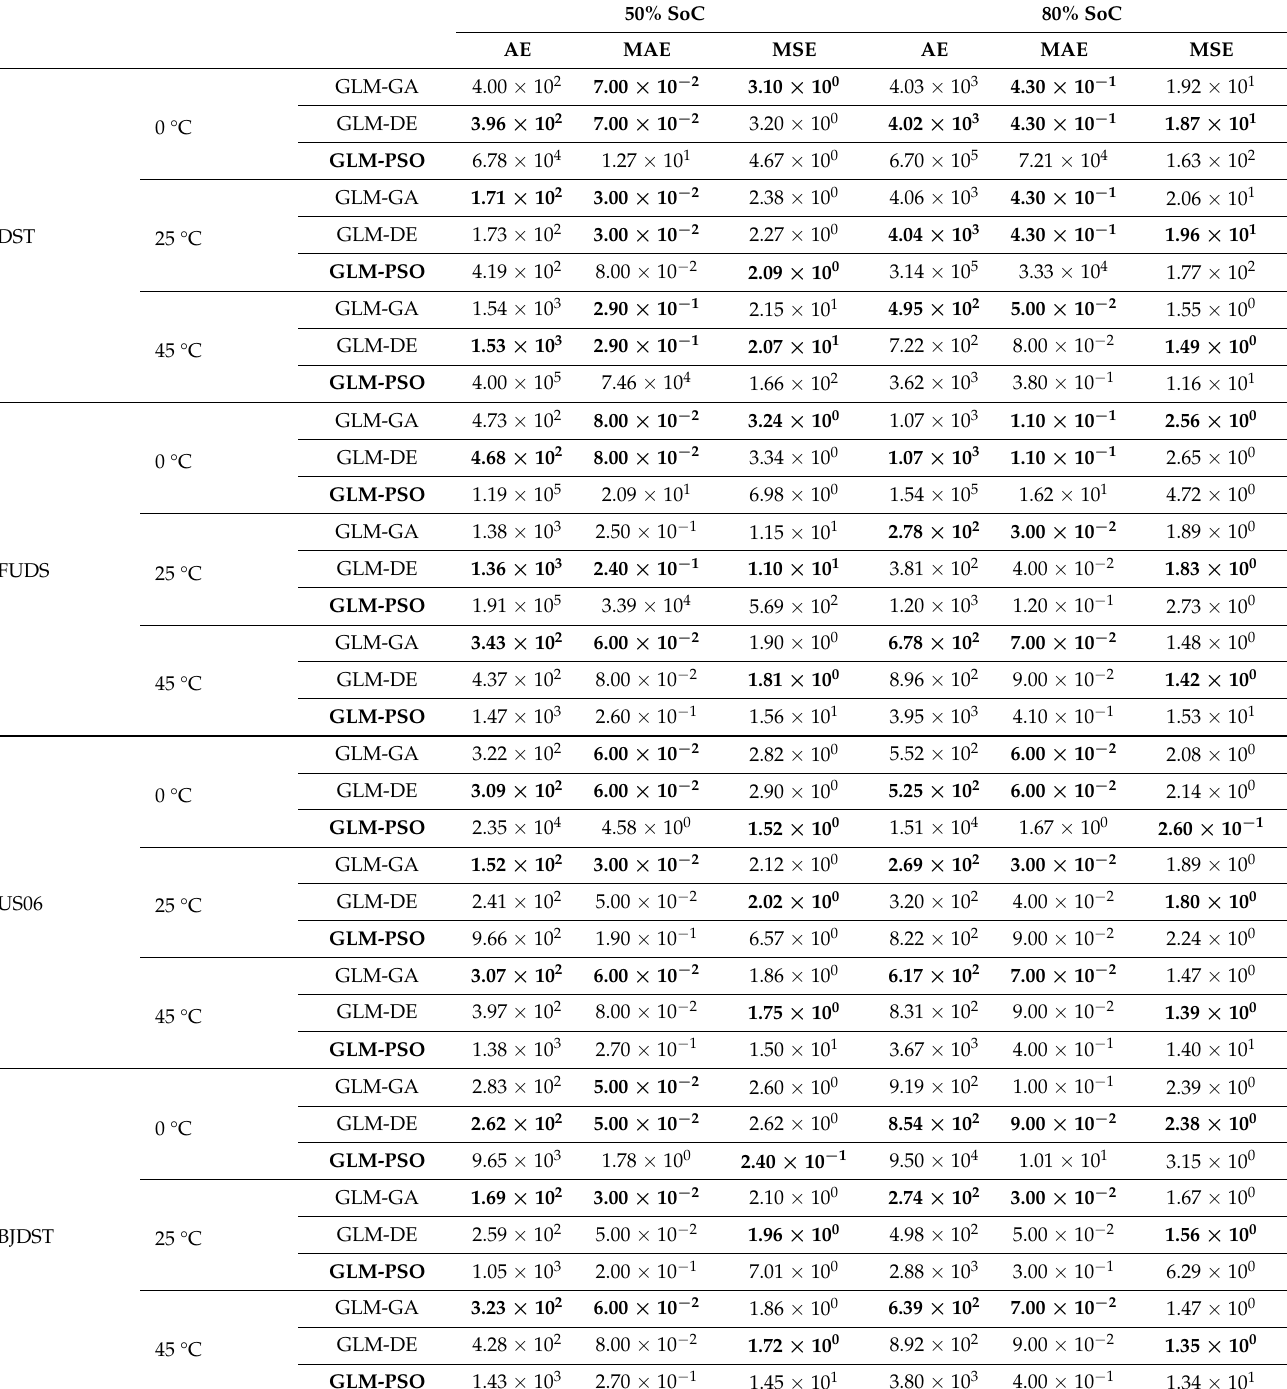
Table 5. Test results for all profiles at different SoC and temperatures for the GLM